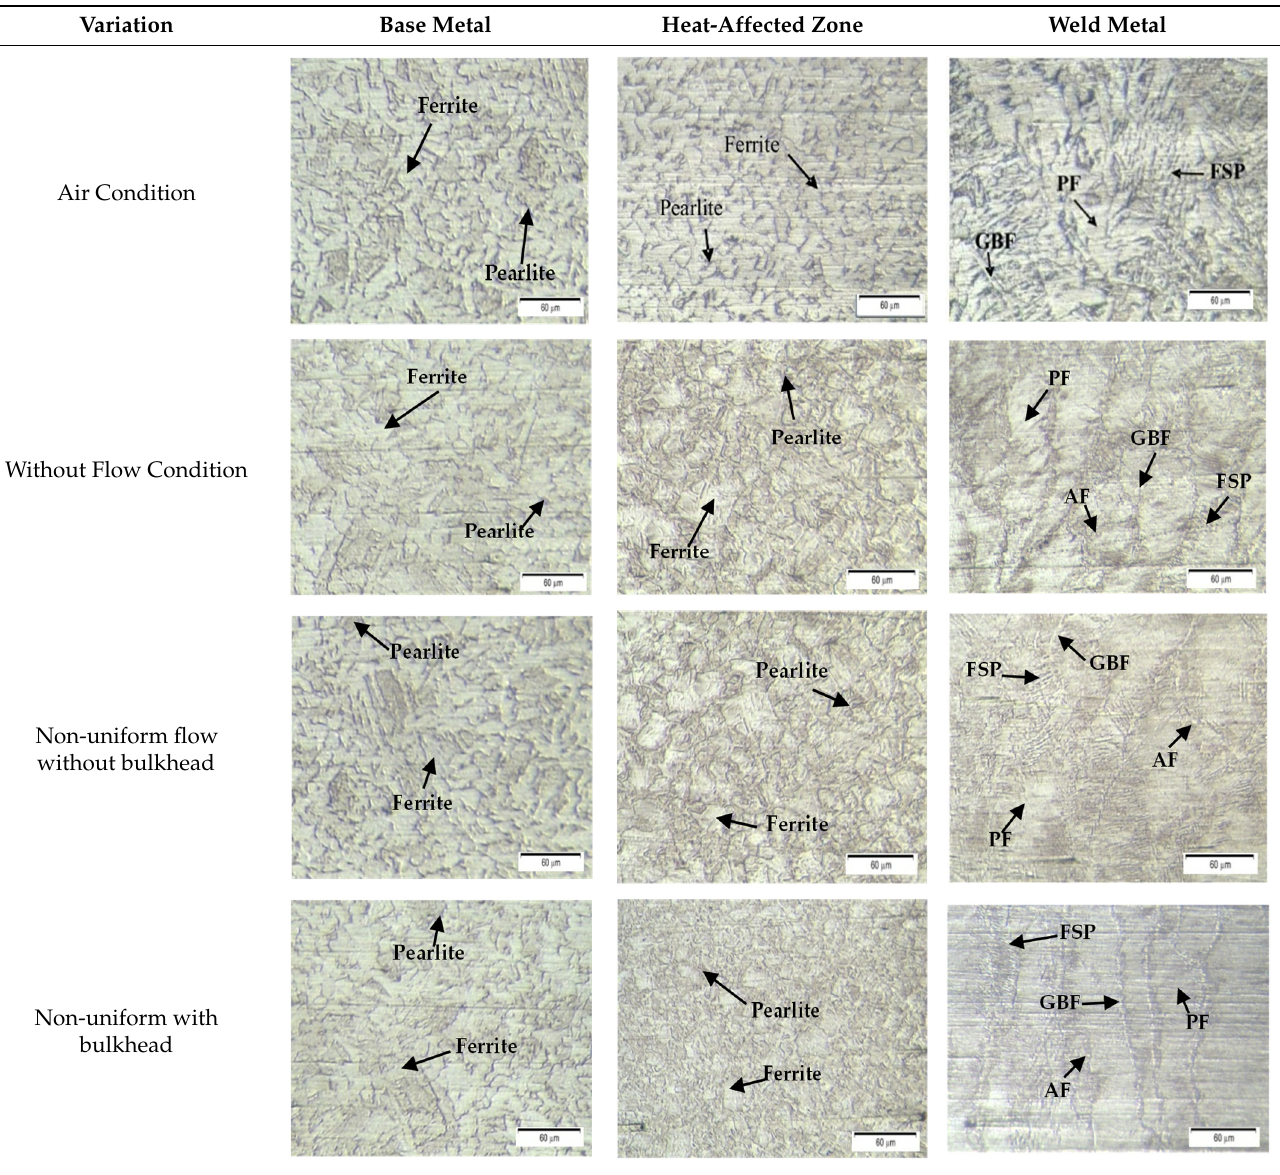
Table 3. Microscopic structures of specimens exposed to different conditions (scale bars for each figure is 60 μ m).